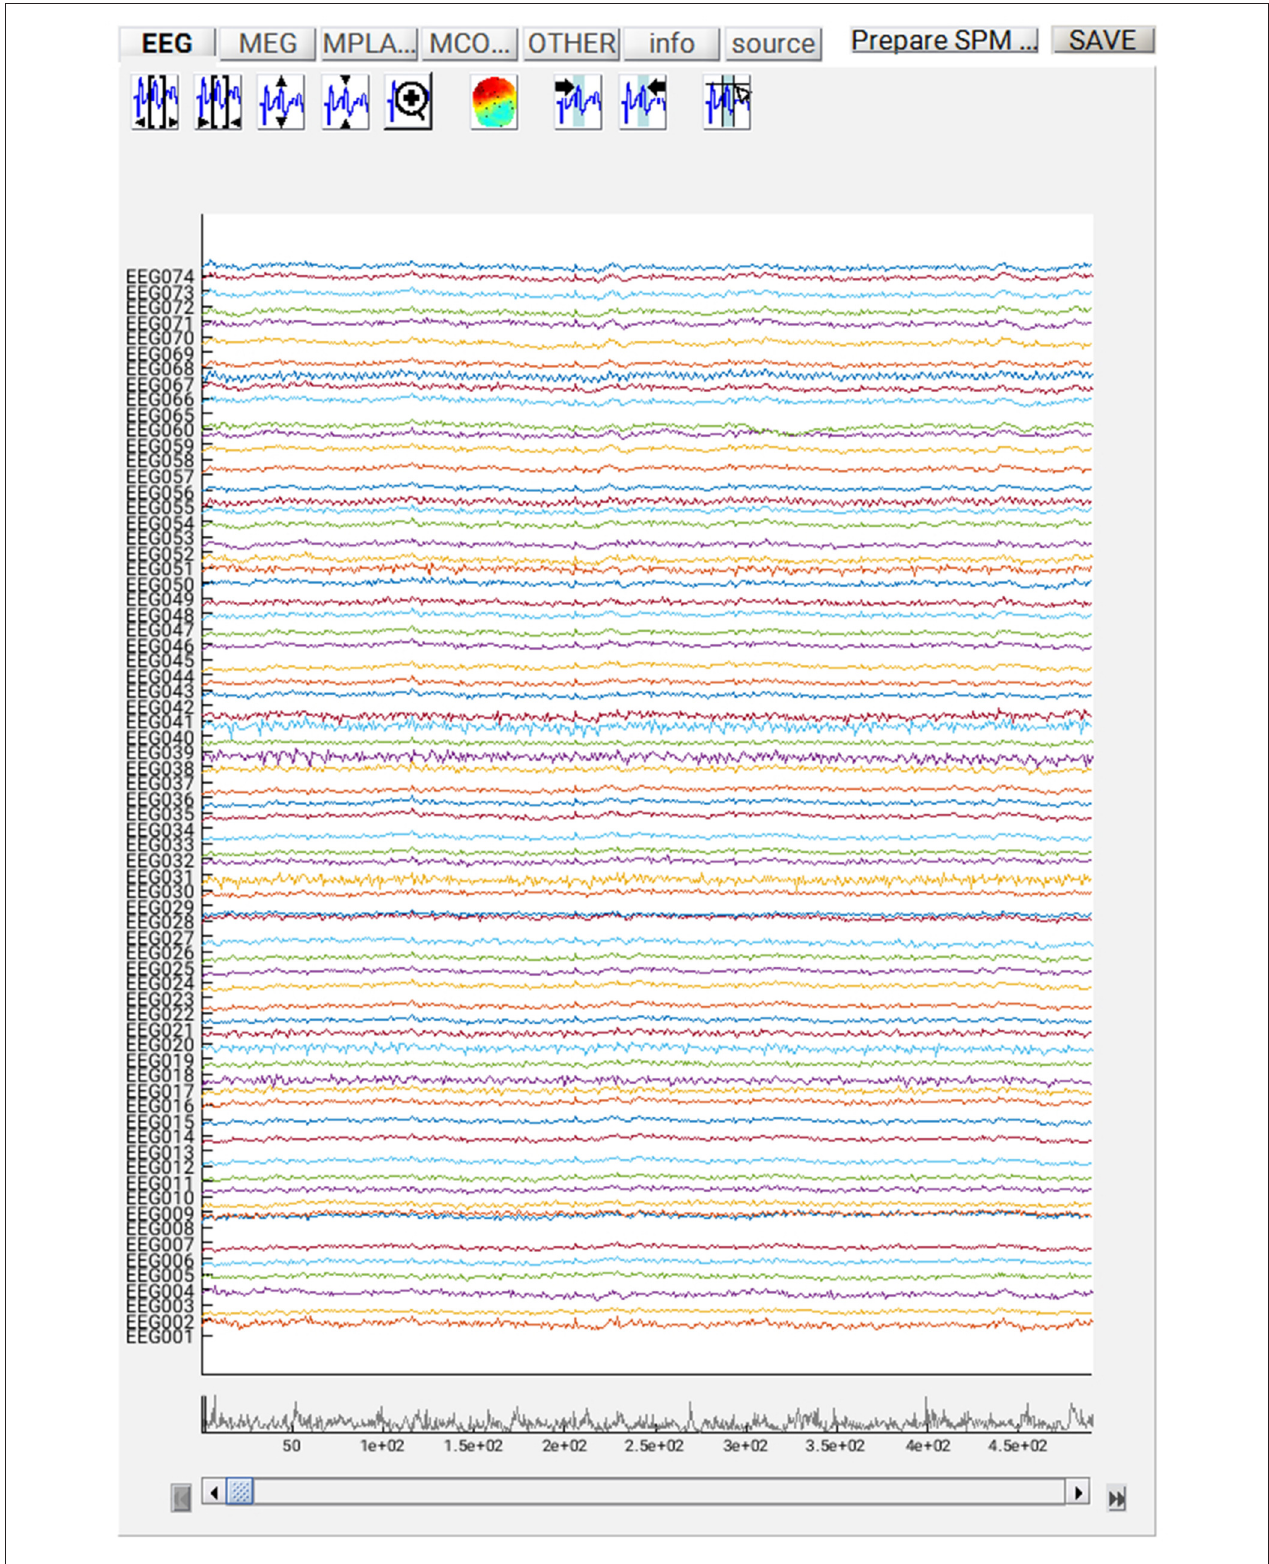
FIGURE 3 | Continuous EEG recordings in SPM graphics